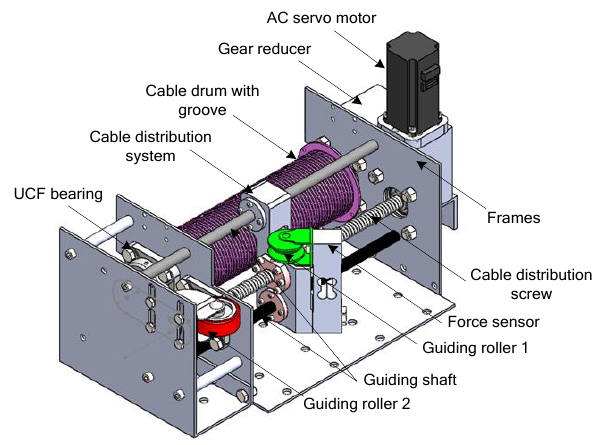
Figure 12. Design of the winch.